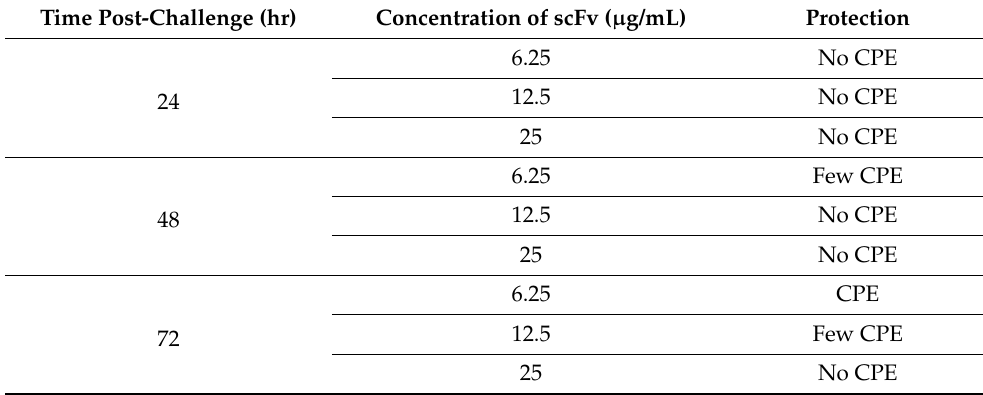
Table 3. The neutralizing ability of recombinant scFv against the G2b PEDV. Time Post-Challenge